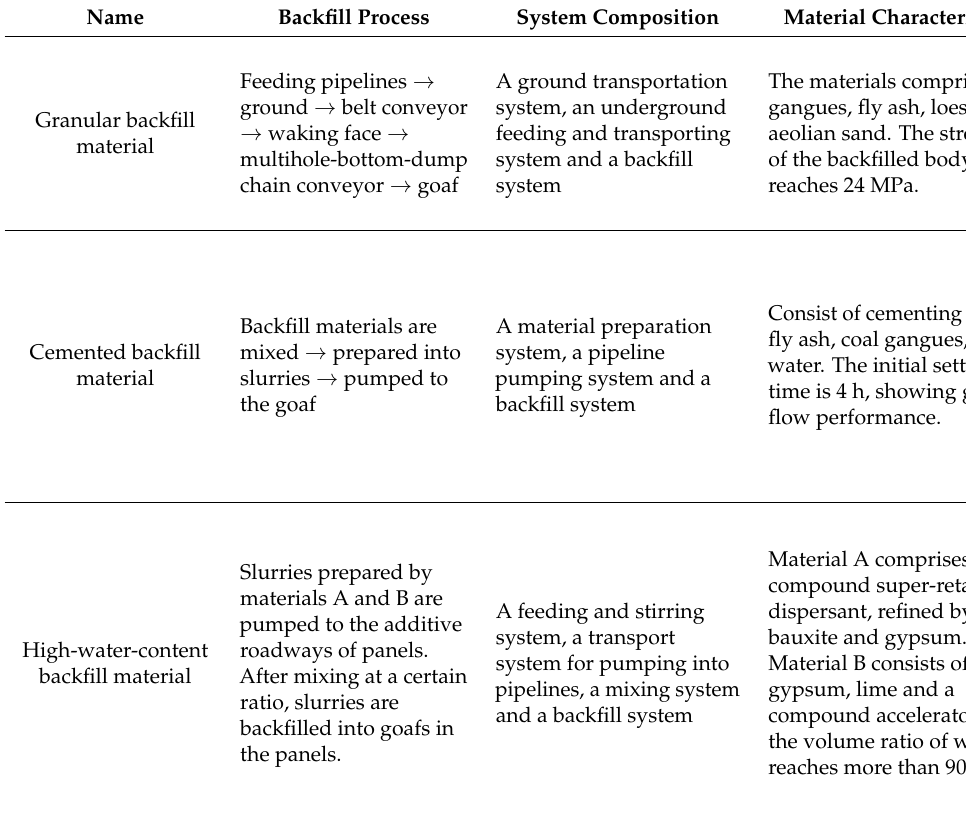
Table 1. Comparison of characteristics of different backfill